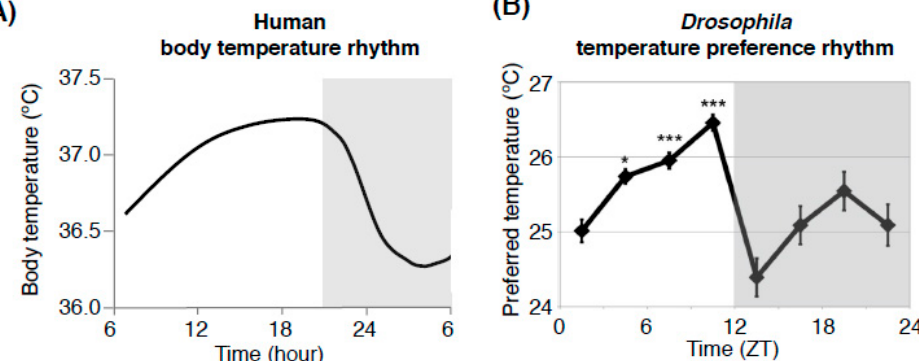
Figure 1. Comparison between the human body temperature rhythm (BTR) and the Drosophila temperature preference rhythm (TPR). The human BTR ( A ) (replotted the figure using an example form Duffy JF et al. 1998, Figure. 3 [3]) and the Drosophila TPR ( B ) (modified from Kaneko et al. 2012, Figure 1 [18]). The shadow area in ( A ) shows the sleep period, and ( B ) shows the dark period. ZT: zeitgeber time. *: p < 0.05, ***: p < 0.001 (comparison to ZT 1-3). Given that the body temperature of